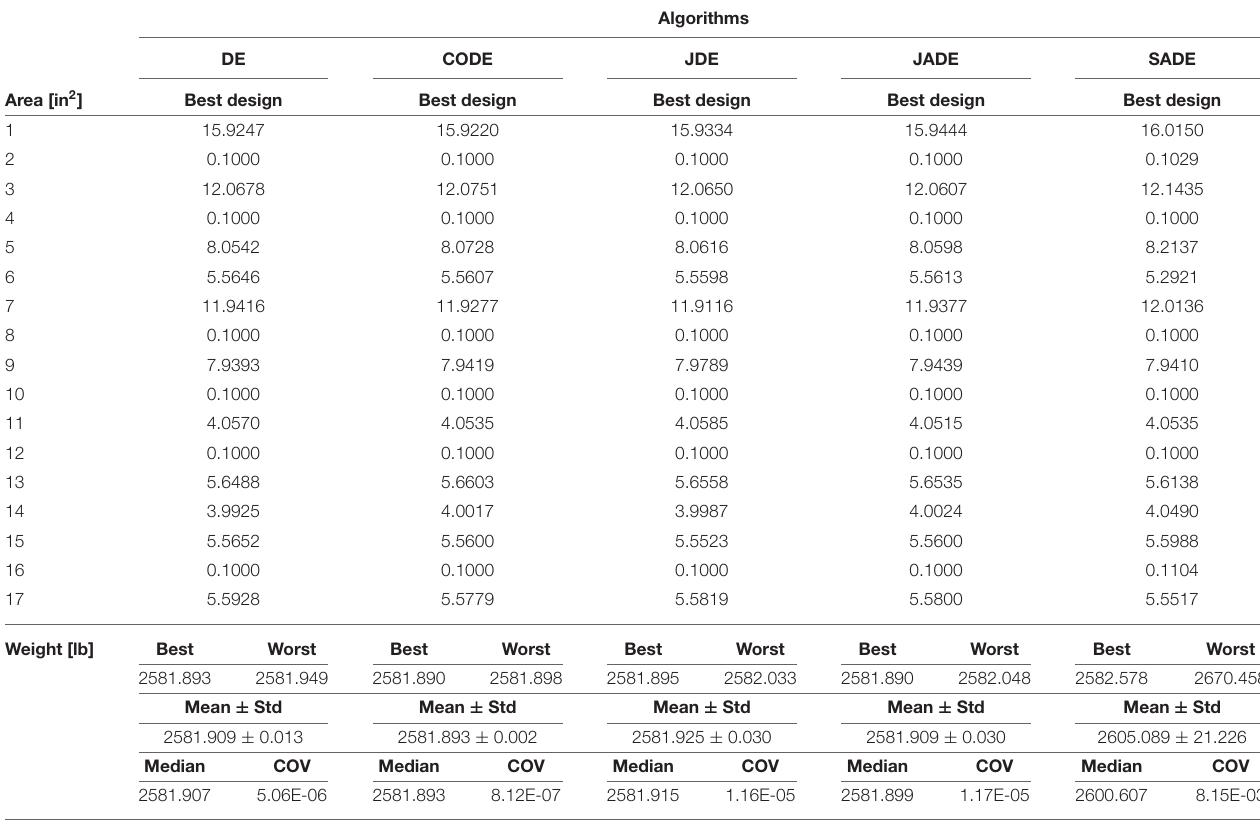
TABLE 7 | Algorithms’ statistical parameters for the 17-bar plane truss problem.